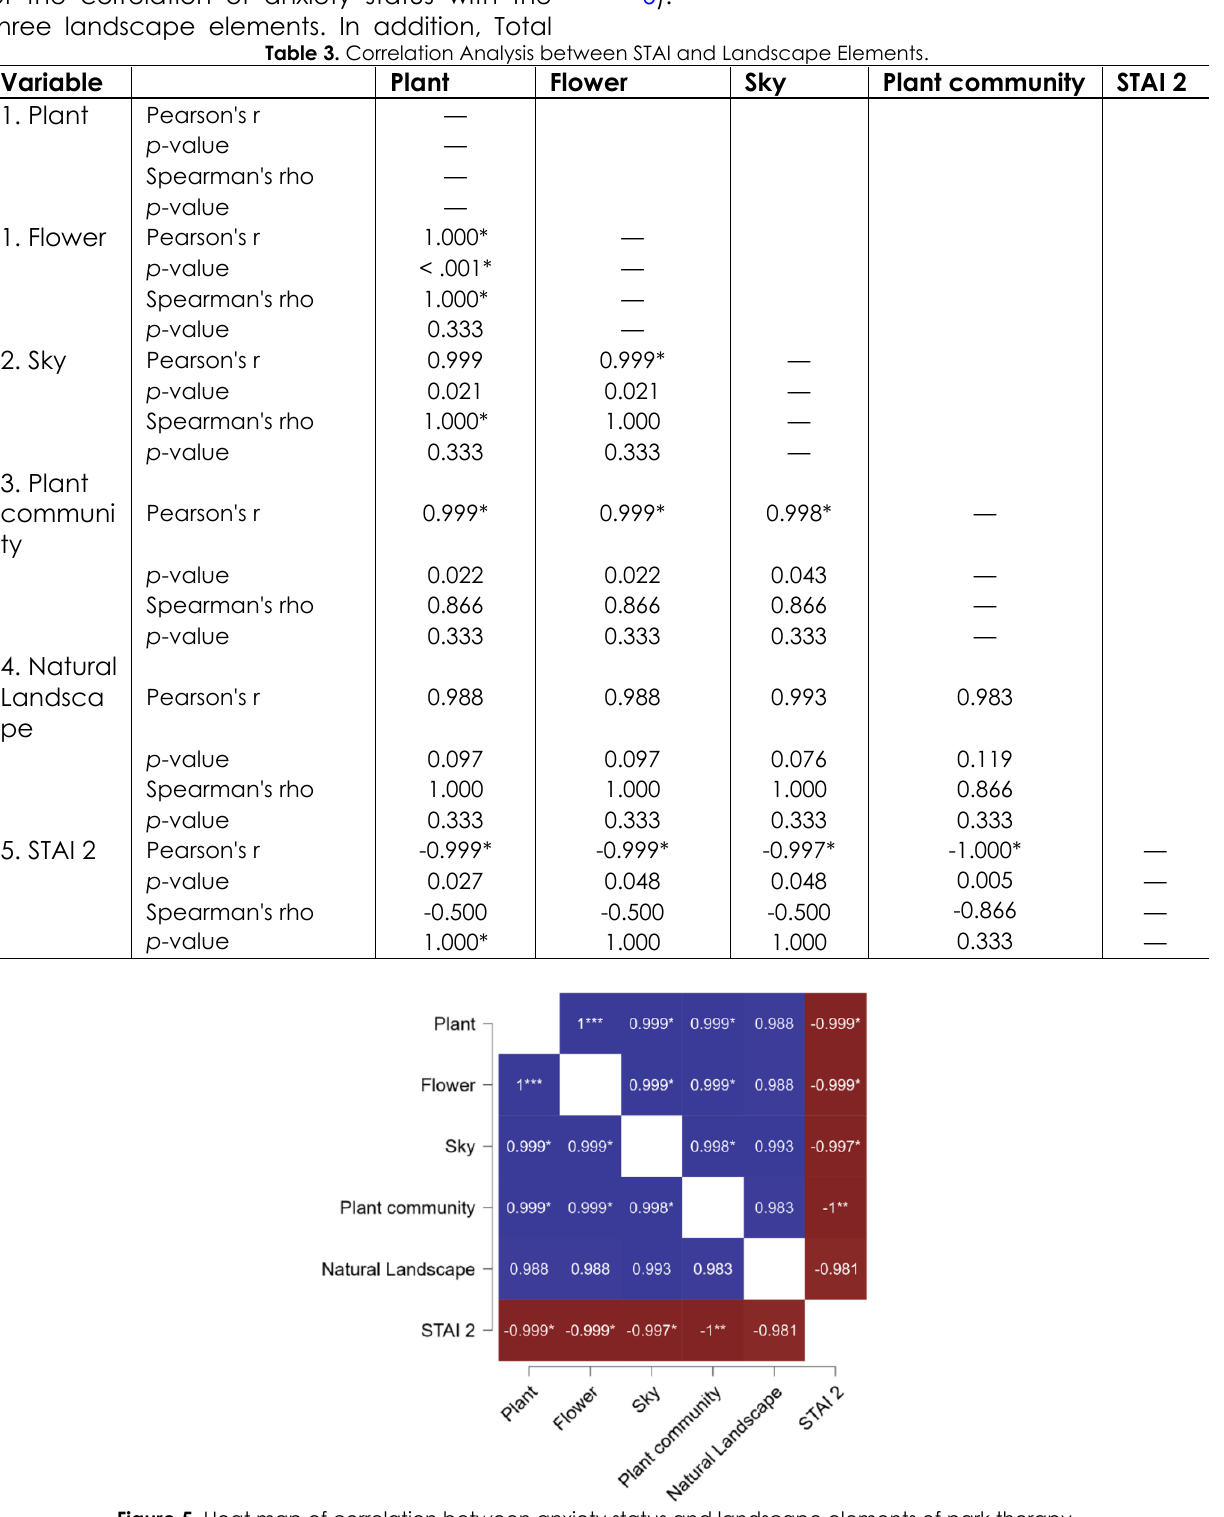
Figure 5. Heat map of correlation between anxiety status and landscape elements of park